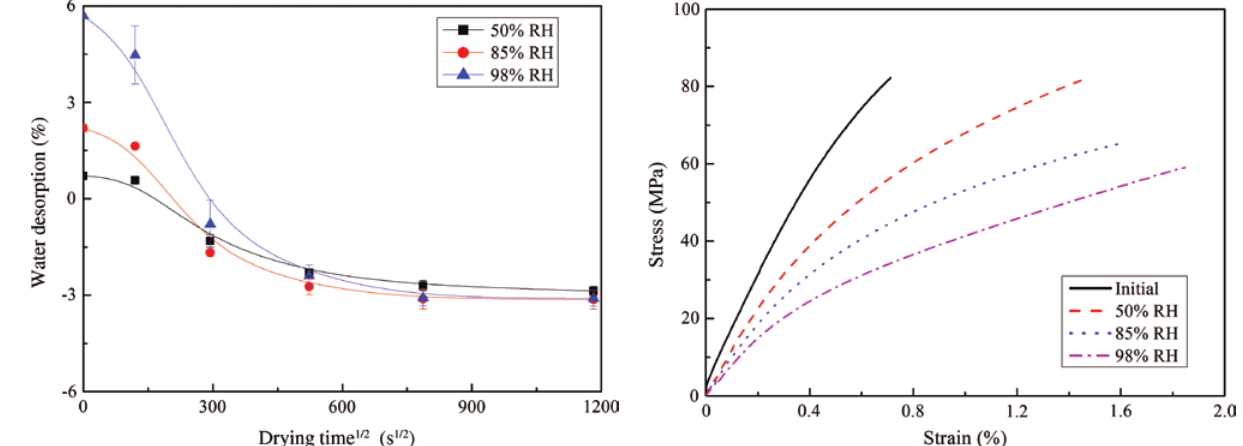
Figure 2 Moisture desorption curves of ramie fiber fabric Figure 3 Typical tensile stress ∼ strain curves of control and aged ramie fiber fabric reinforced phenolic resin samples in